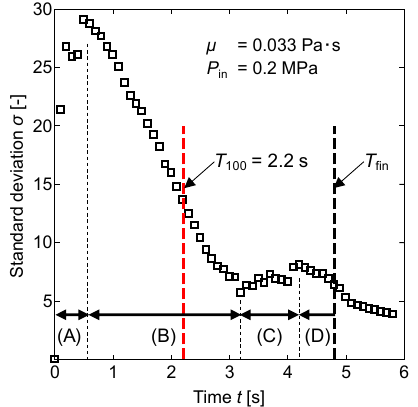
Figure 13. Standard deviation.